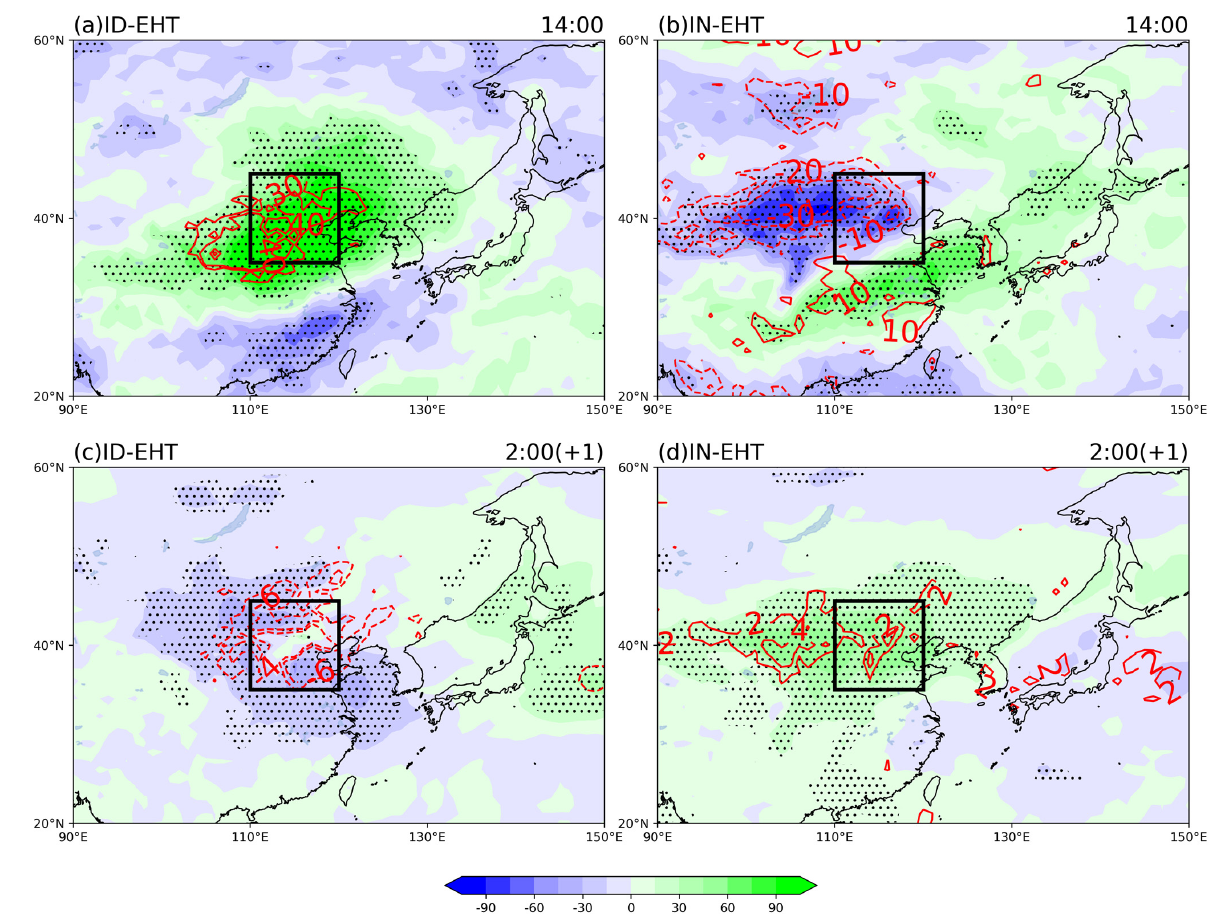
Figure 2. Composite anomalies of surface net short-wave flux (shading; units: W/m 2 ) at 14:00 ( a ) and surface net long-wave radiation flux (shading; units: W/m 2 ) at 2:00 of the next day ( c ) for ID-EHT; ( b , d ) are same as ( a , c ) but for IN-EHT. The red solid and dotted contours represent surface sensible heat flux anomalies with 10 intervals in ( a , b ) and 2 intervals in ( c , d ). Black dots indicate the anomalies significant at the 95% confidence